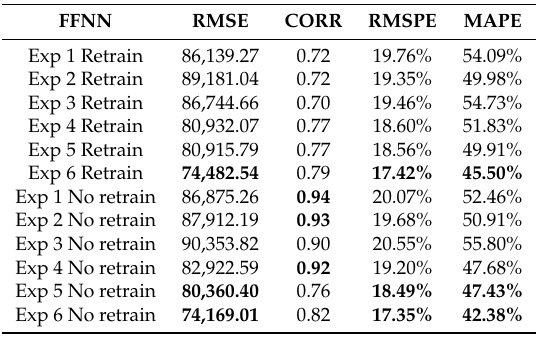
Table 5. Averaged metrics for all experiments with and without retraining. Best values are in bold